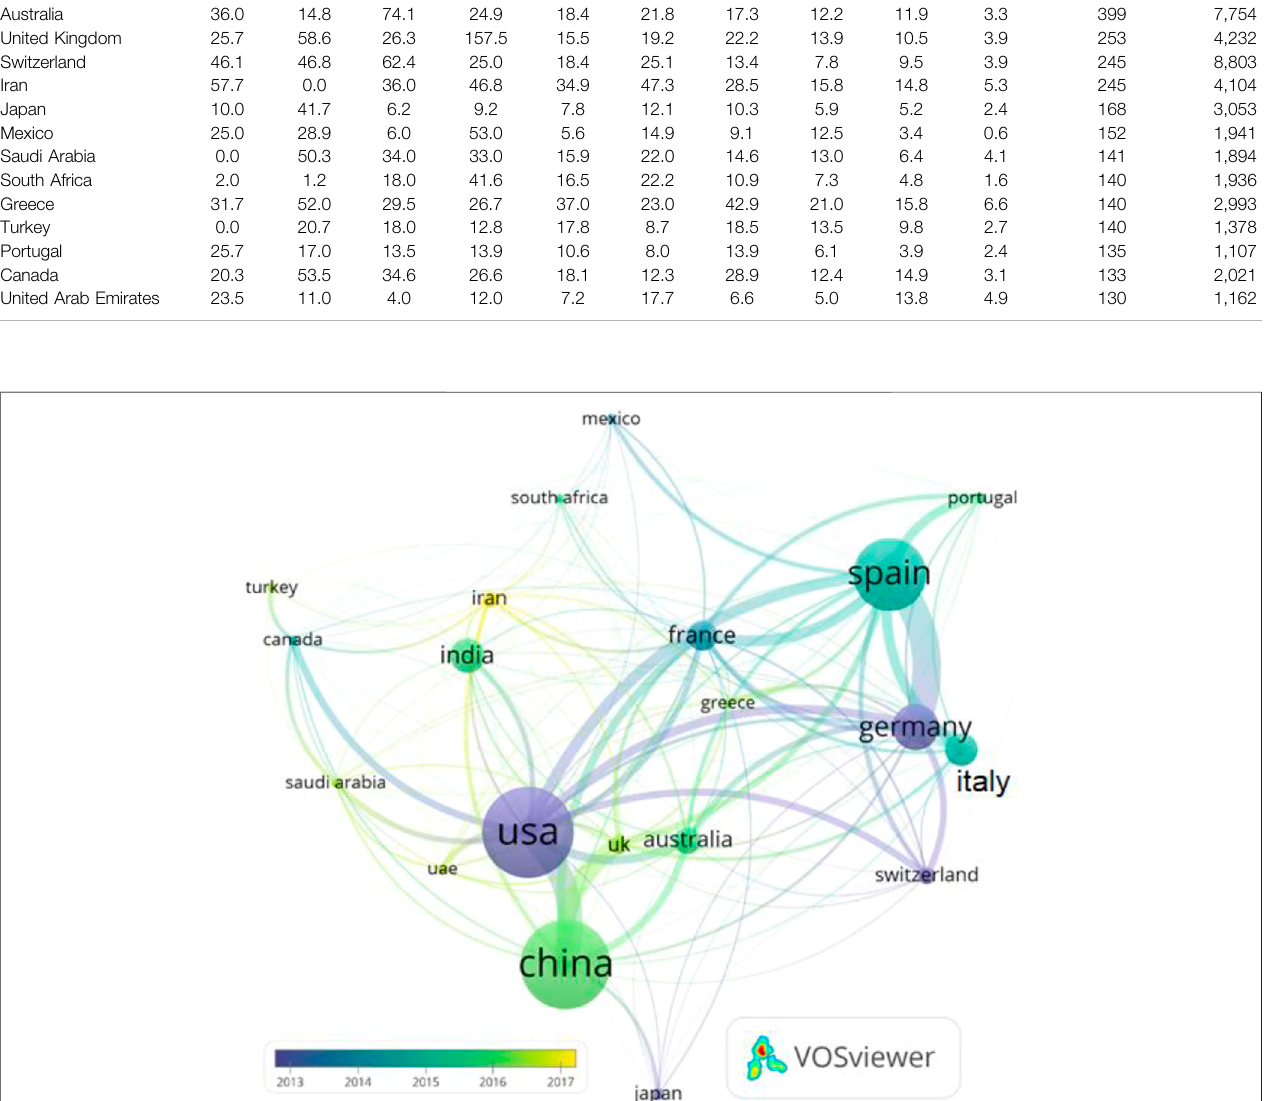
Frontiers in Mechanical Engineering |